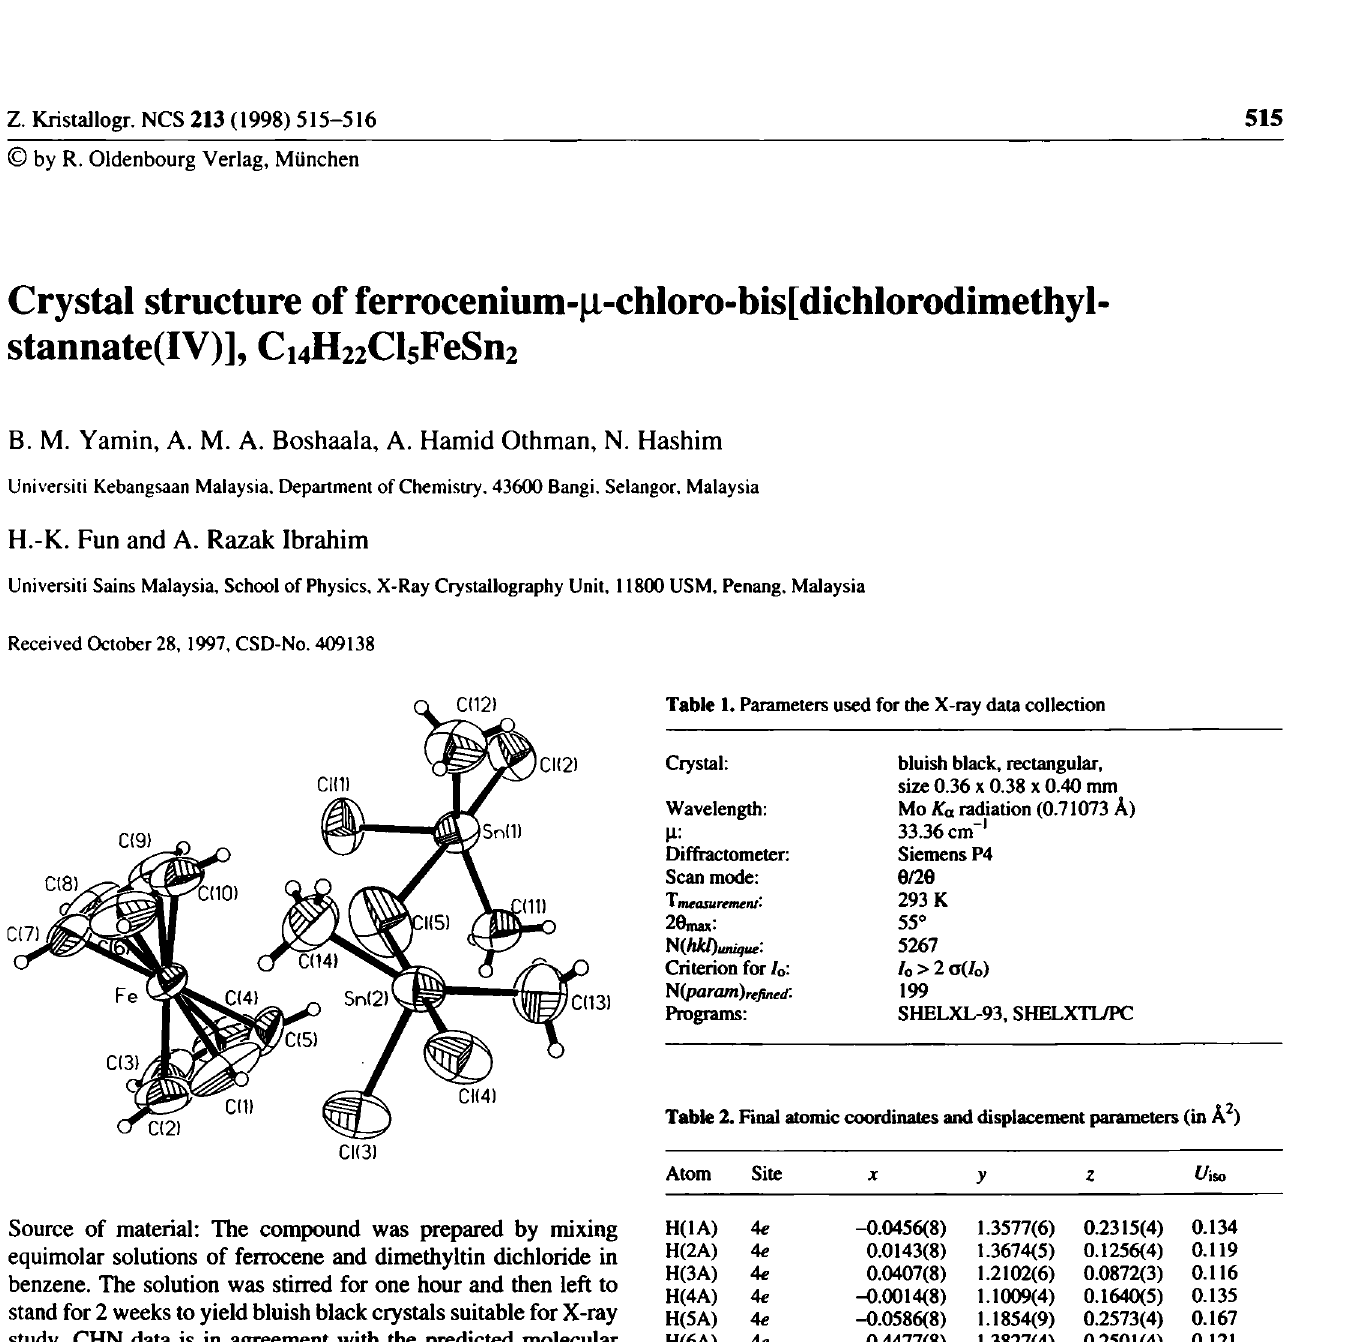
Table 2. Final atomic coordinates and displacement parameters (in Â^)